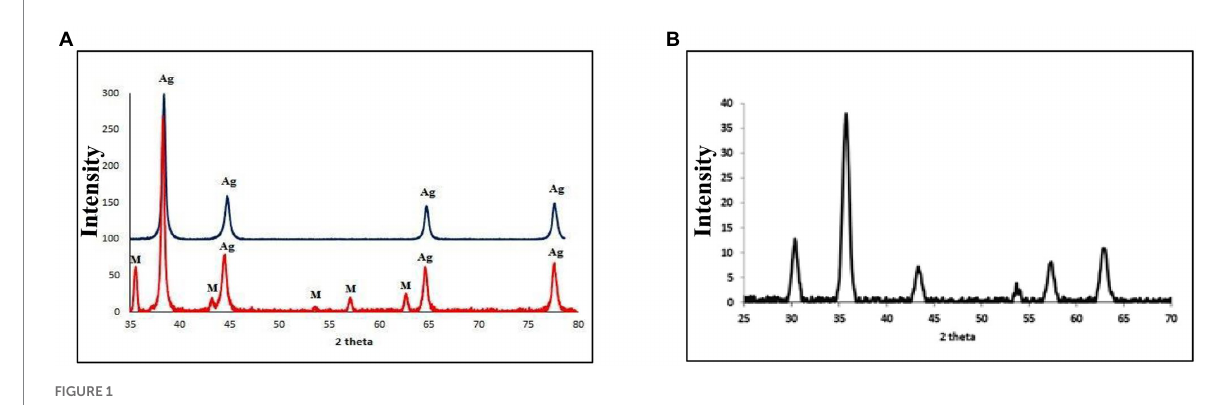
FIGURE 1 (A) X-ray diffraction (XRD) of silver nanoparticles (with blue color), silver/magnetite core shell nanoparticles (with red color). (B) XRD OF magnetite nanoparticles.